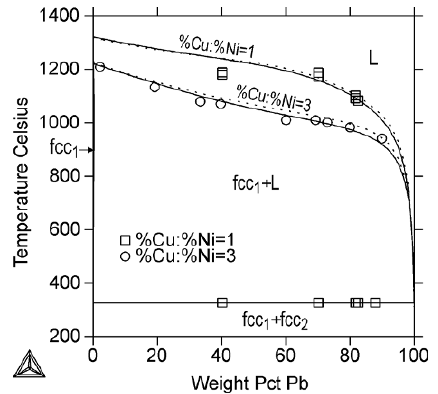
Figure 7. Calculated isopleths of the Cu-Ni-Pb system at composition ratios of wt%Cu / wt%Ni=1 and wt%Cu / wt%Ni=3, together with experimental data points [14,15]. Solid lines refer to the calculations of this study and dashed lines refer to those of